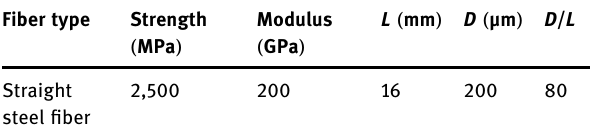
Table 2: Mix proportions of NC substrate and di ff erent overlay materials, kg/m 3